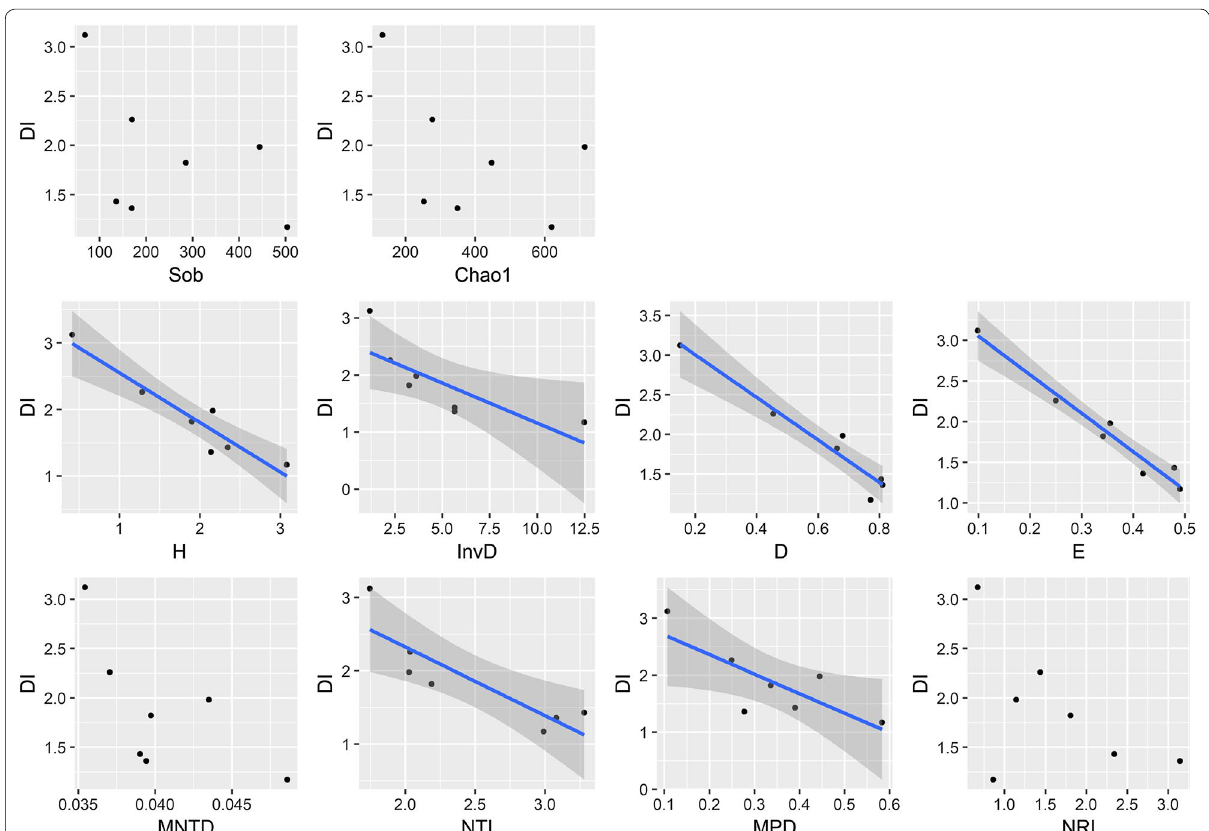
Fig. 6 Correlation between plant health and the characteristics of phyllosphere microbial community. DI disease index, Sob observed OTU number, Chao1 Chao1 richness index, H Shannon diversity index, InvD inverse Simpson diversity index, D Simpson diversity index, E Pielou evenness, MNTD mean nearest taxon distance, NTI near taxon index, MPD mean phylogenetic distance, NRI net relatedness index. The blue lines and shades represent the regression lines with 95% confidence intervals. Pearson correlation indexes and p -values are shown in Additional file 1: Table